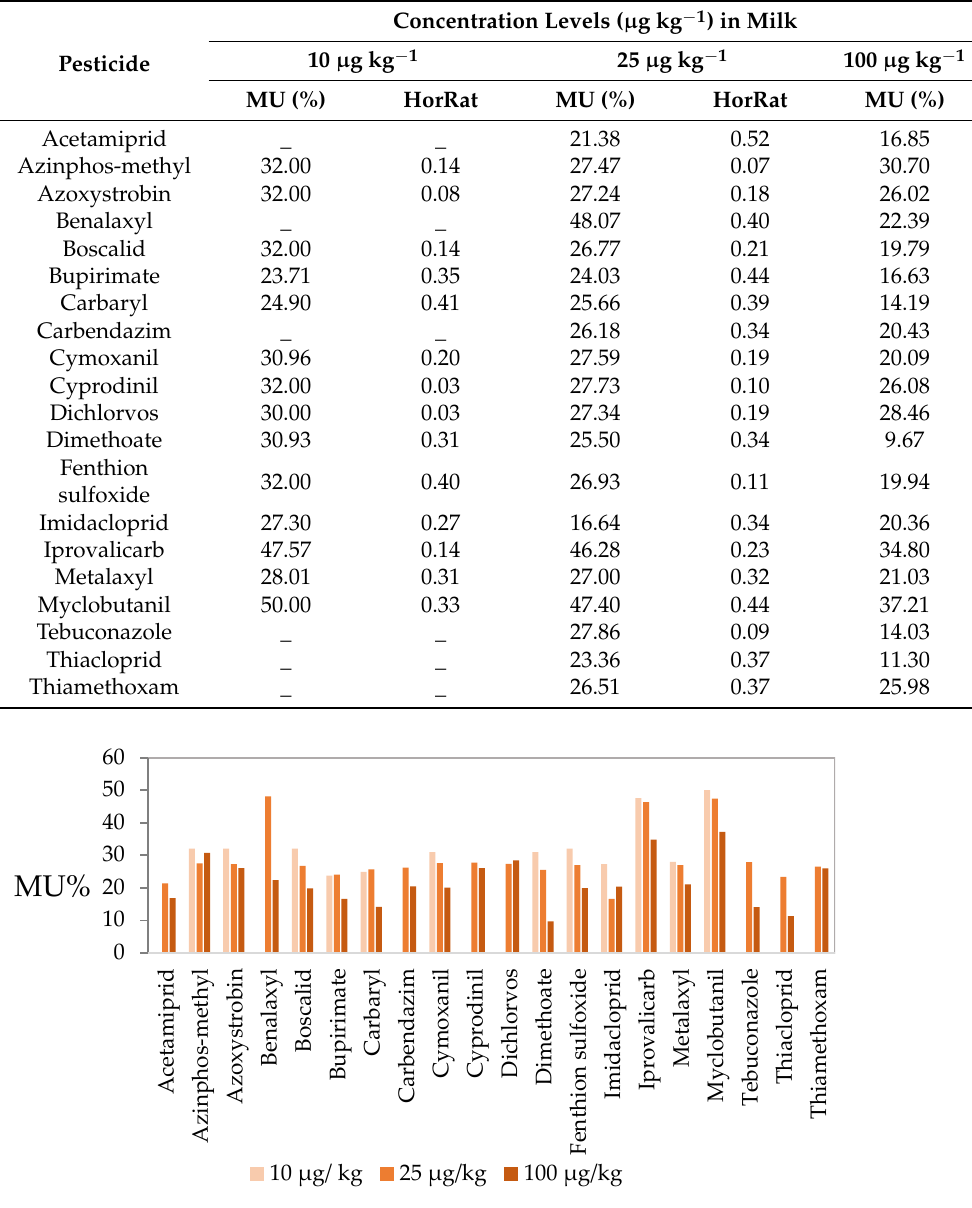
Table 4. Measurement uncertainty (MU %) for milk in concentrations 10, 25, and 100 µ g kg − 1 (k = 2,